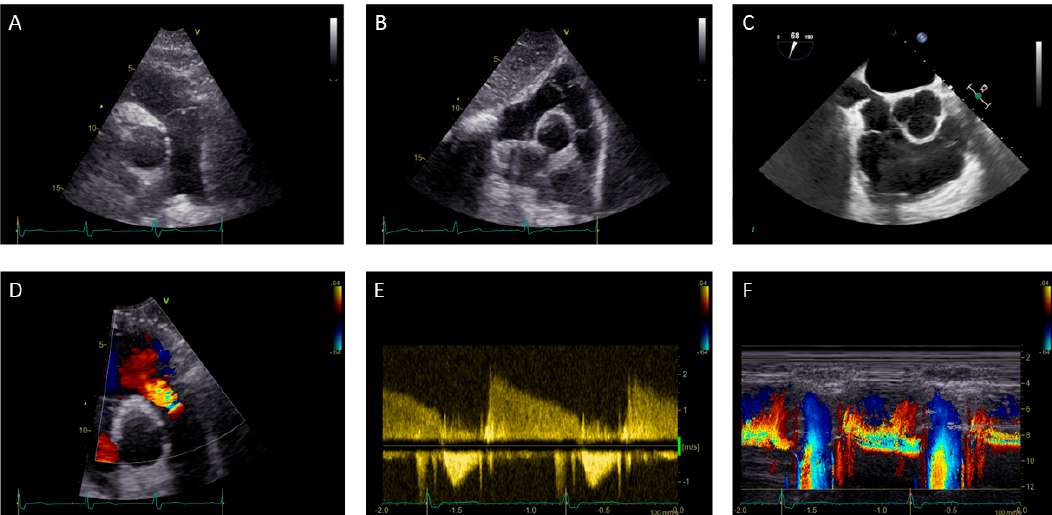
Figure 1. ( A – C ) Assessment with transthoracic and transesophageal echocardiography of the pul- monary valve in a 50-year-old female patient: ( A ) Parasternal short-axis view with focus on pulmo- nary valve and pulmonary artery; ( B ) Subcostal view; ( C ) Mid-esophageal right ventricle inflow- outflow view. ( D – F ) Transthoracic echocardiography assessment of pulmonary regurgitation in a 60-year-old male patient: ( D ) Detection of pulmonary regurgitation by color flow Doppler imaging; ( E ) Continuous wave Doppler of pulmonary regurgitation flow; ( F ) Color M-mode demonstrates holodiastolic regurgitation jet.